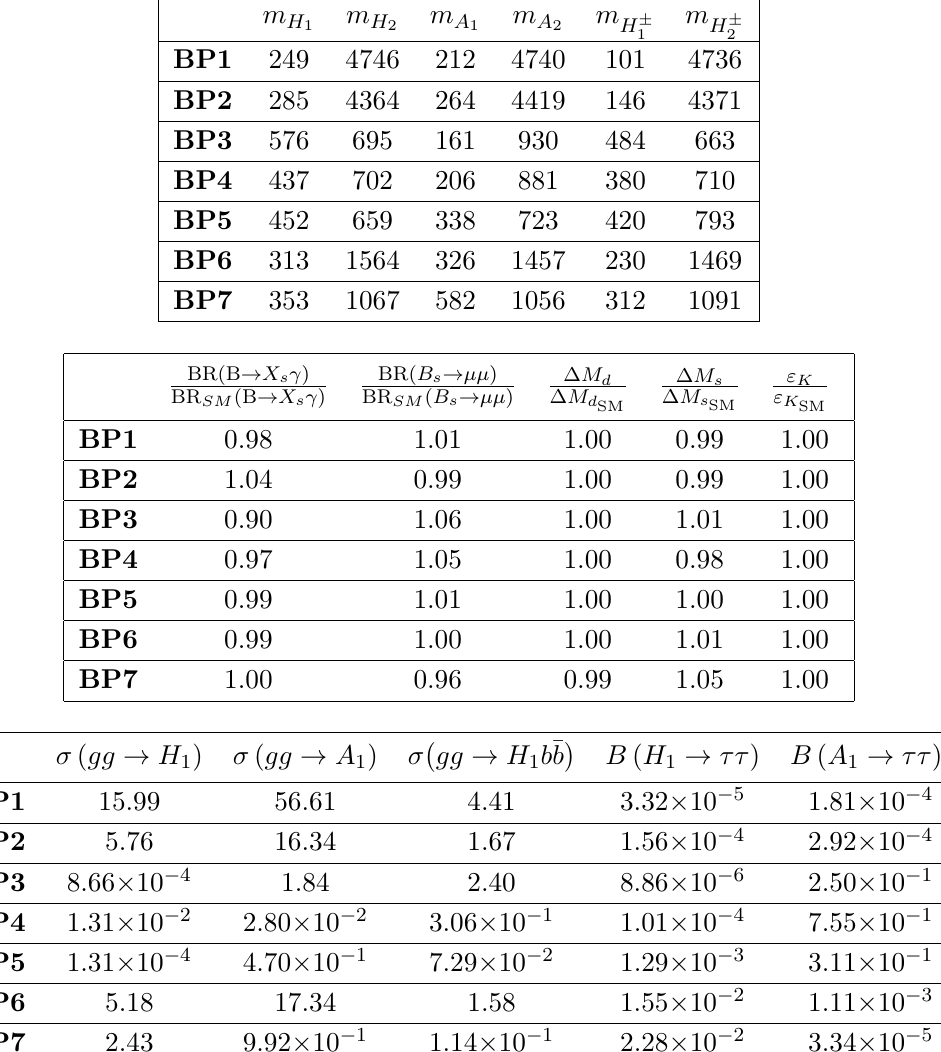
Table 3 . A selection of seven benchmark points. All masses are given in GeV and cross sections in pb. These correspond to the lightest scalars found that respect all QFV, electroweak, Higgs and theoretical constraints (BP1–BP4), and to three early discovery/exclusion points that mostly approach the experimental bounds in figure 9 (BP5) as well as in figure 10-right (BP6) and figure 10- left